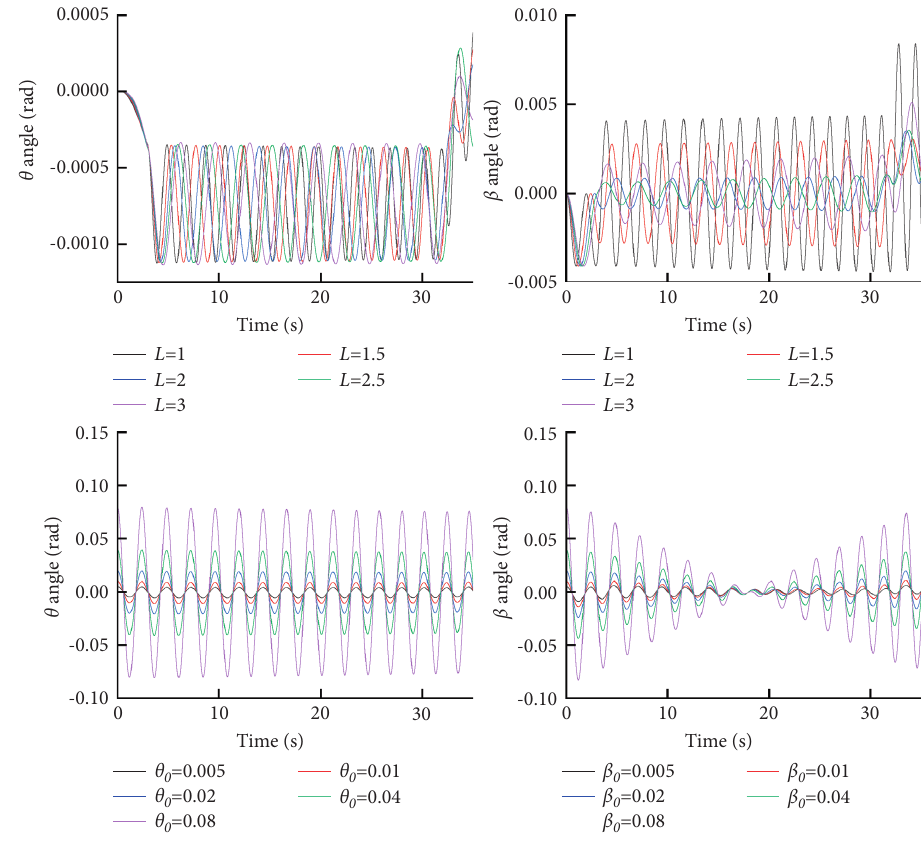
Figure 13: Response of L , θ